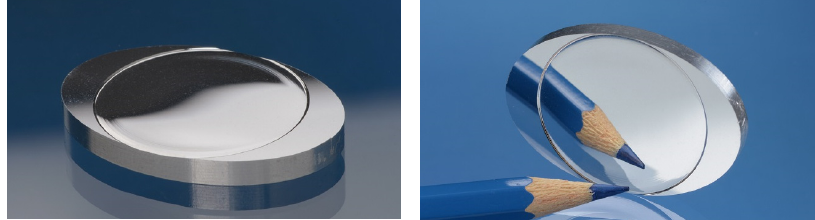
Figure 4. Pictures of the freeform mirror, which generates the optimized temperature distribution (Supplied by the company Innolite, Aachen,